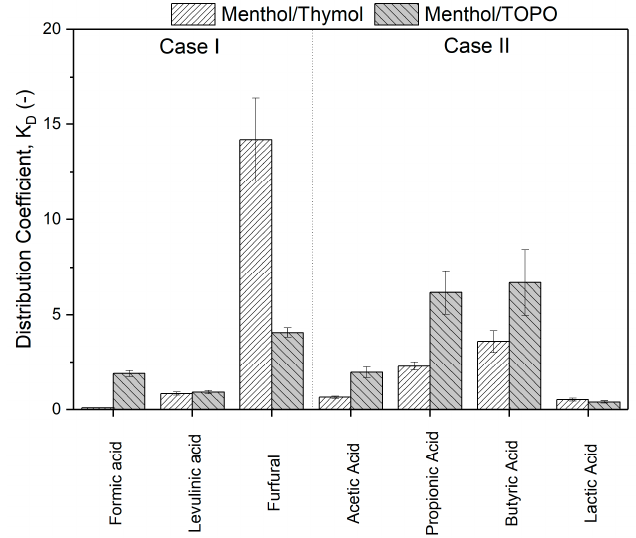
Figure 2. The distribution coefficients of formic acid, levulinic acid, and furfural (Case I), and acetic acid, propionic acid, butyric acid, and L-lactic acid (Case II). Each extraction was done with a 1:1 molar ratio of thymol and L-menthol, and a 1:3 molar ratio of TOPO and L-menthol DES at an S:F ratio of 1 (mass basis) at 25 °C. The error bars represent the combined experimental and analytical errors.